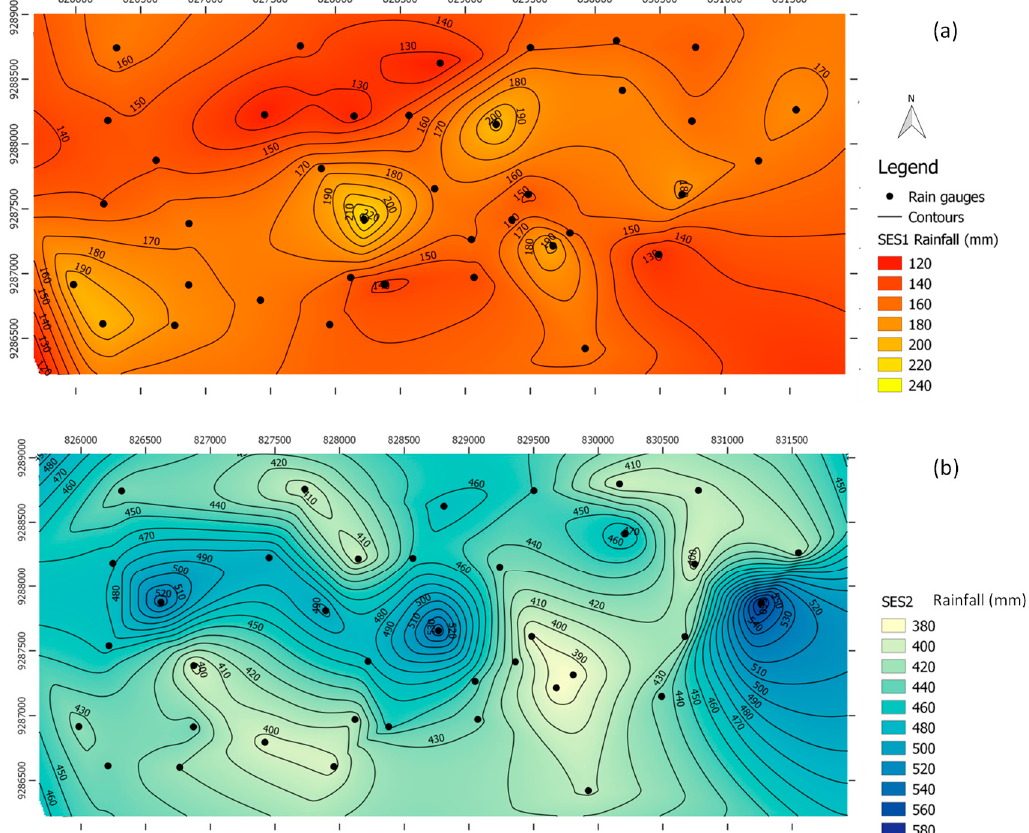
Figure 6. Isohyets of the total seasonal rainfall (mm) during ( a ) SES1 and ( b ) SES2.